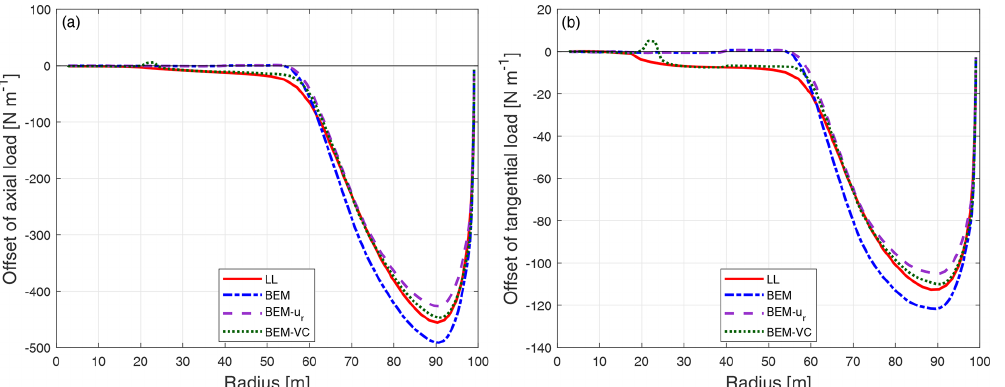
Figure 21. Comparison of the difference of the axial load (a) and tangential load (b) of the dihedral blade W-1-U20 compared to the baseline blade calculated from different models. The wind speed is 20ms − 1 , the tip-speed-ratio is 4.5 and the additional twist angle θ p is 18.51 ◦